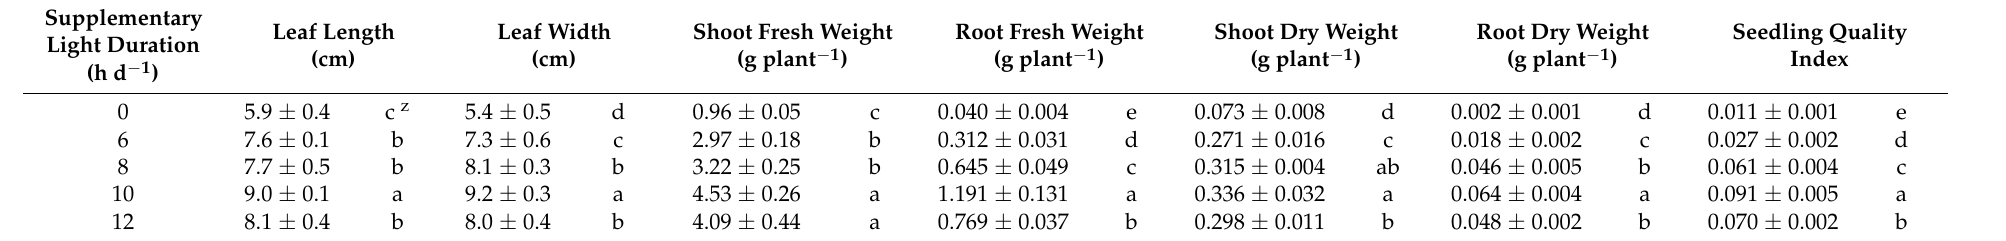
Table 2. Growth and morphological properties of greenhouse-grown cucumber seedlings with supplementary light duration at 0, 6, 8, 10, and 12 h d − 1 with the same daily light integral provided by light-emitting